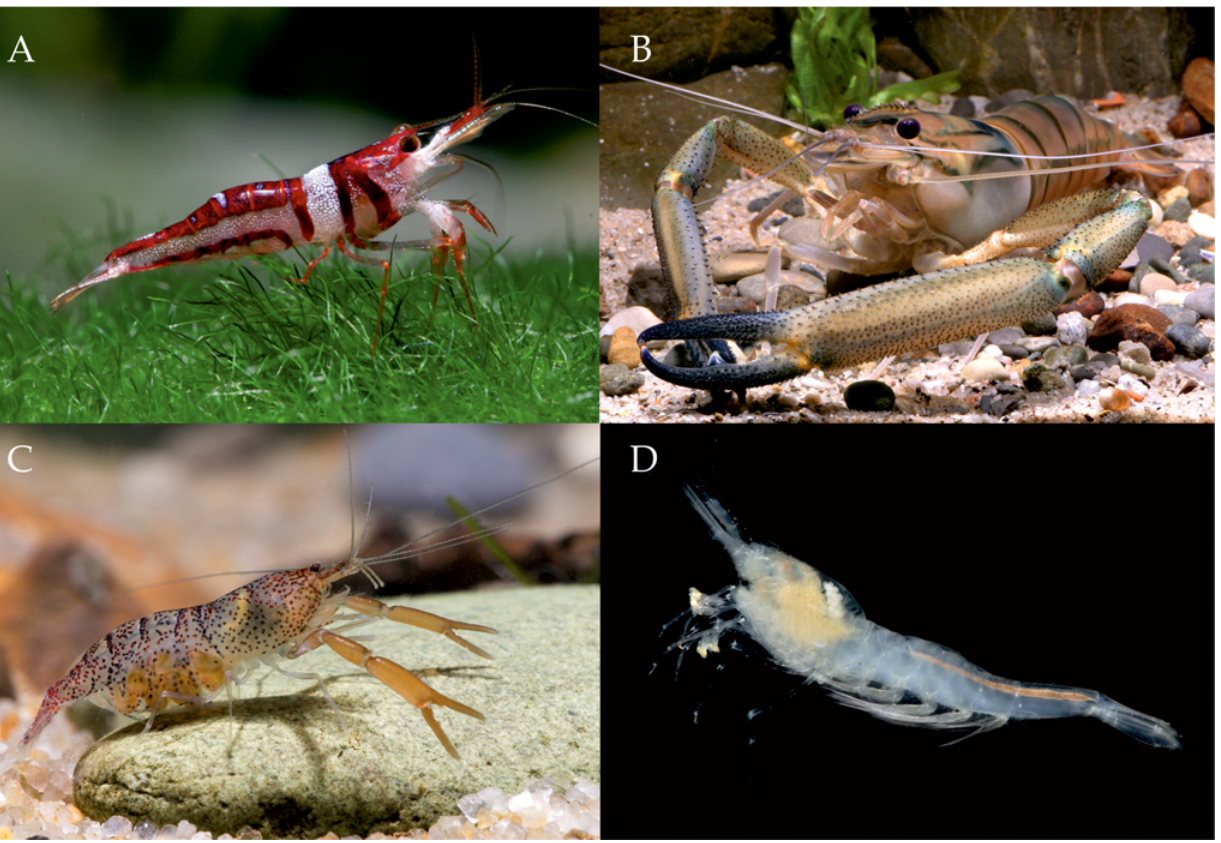
Fig 1. Examples of freshwater shrimps with assessment of their risk of extinction status. (A) Caridina woltereckae ( EN ), endemic to Lake Towuti (Sulawesi), currently under threat due to overharvesting for the aquarium trade, pollution and invasive fish species; (B) Macrobrachium vollenhoveni ( LC ), a widespread African species, ranging from Senegal to Angola; (C) Euryrhynchus amazoniensis ( LC ), a widespread Amazonian species; (D) Palaemonias alabamae ( EN ), known from only four cave systems in Alabama, USA, currently under threat from groundwater abstraction and habitat